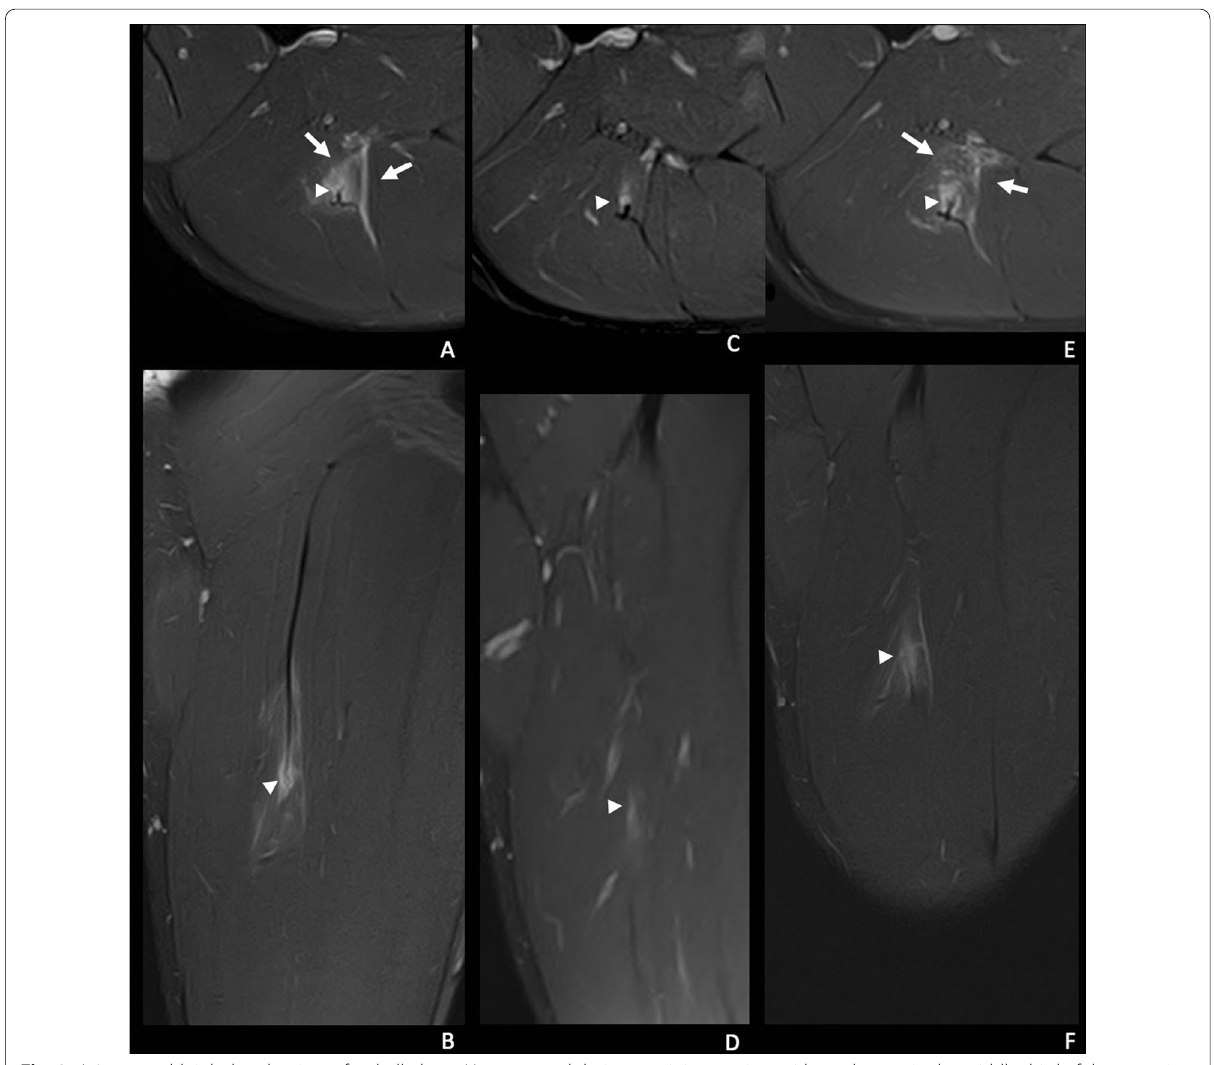
Fig. 3 A 21‑year‑old right leg dominant football player. He presented during a training session, with tenderness in the middle third of the posterior aspect of the left thigh, and inability to continue training. A , B Axial and coronal T2‑weighted fat‑saturated images from a baseline MRI show myotendinous injury of the intramuscular portion of the proximal MTJ of the biceps femoris long head, I Mp 3r 0 (MLG‑R classification [33]). There is a transversal tear of the connective tissue with loss of tension (arrowhead) and interstitial and intermuscular oedema (arrows). C , D Axial and coronal T2‑weighted fat‑saturated images of the pre‑RTP MR (37 days post‑injury), show a small transversal peripheral tendinous tear (arrowhead) with a trace interstitial oedema. E , F Reinjury 1 day later. Axial and coronal T2‑weighted fat‑saturated images show a thicker transversal tendinous tear with fibre muscle tear (arrowhead) and more interstitial oedema and intermuscular oedema